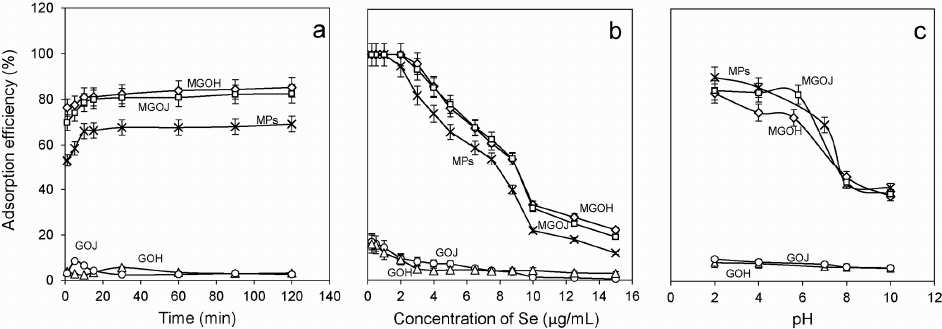
Figure 5. ( a ) The variation of Se(IV) adsorption efficiency from the interaction time for unmodified (GOH, GOJ, MPs) and the modified materials (MGOH and MGOJ) in a solution of initial Se(IV) concentration of 5 µ g/mL; ( b ) comparison of the effect of Se(IV) concentration on the adsorption efficiency of different materials considered (MPs, GOH, GOJ, MGOH, MGOJ); and ( c ) the influence of the pH values of different carbon materials used on the adsorption efficiency of Se(IV) from its aqueous solution containing 5 µ g/mL.